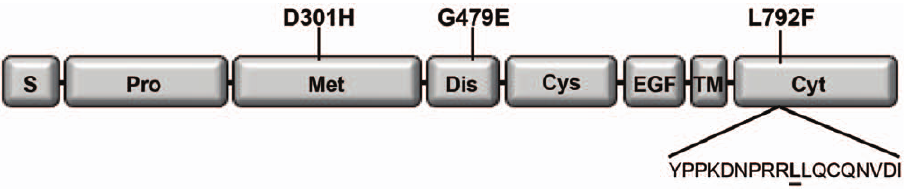
Figure 1. Schematic illustration of ADAM12 indicating the published breast cancer-associated mutations and the di-leucine motif in the cytoplasmic tail. Schematic illustration of the domain organization of ADAM12. S: Signal peptide; Pro: Prodomain; Met: Metalloprotease domain; Dis: Disintegrin domain; Cys: Cysteine-rich domain; EGF: EGF-like domain; TM: Transmembrane domain; Cyt: Cytoplasmic tail. Positions of the three breast cancer-associated mutations are indicated and the amino acid sequence containing the di-leucine motif is